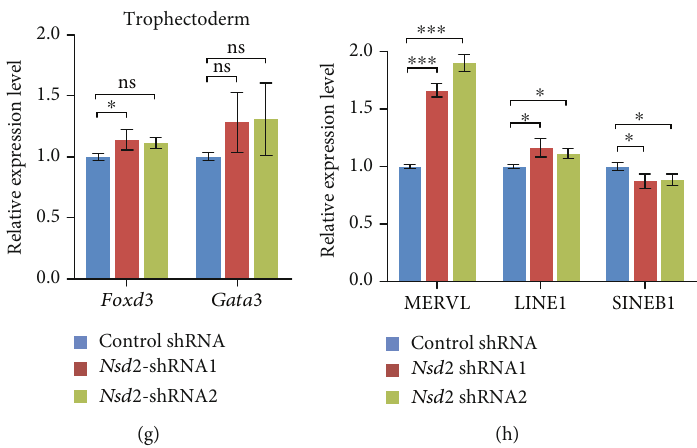
Figure 2: Depletion of Nsd2 in ESCs. (a) qPCR analysis of the relative expression levels of Nsd2 after Nsd2 depletion in ESCs with normalization to Gapdh . Data were plotted as mean ± s : e : m : , n = 3 biological repeats. (b) Cell morphology of Nsd2 depletion in ESCs. Scale bar, 100 μ m. (c) qPCR analysis of pluripotent genes ( Oct4 , Sox2 , and Nanog ) in ESCs with Nsd2 depleted. (d – g) qPCR analysis of endoderm markers Foxa2 and Sox17 (d), mesoderm markers Gata4 and Nkx2.5 (e), ectoderm markers Msx1 and Pax6 (f), and trophectoderm markers Foxd3 and Gata3 (g). (h) qPCR analysis of the expression levels of MERVL and other retrotransposons (LINE1, SINE B1) after Nsd2 depletion in ESCs. The results were normalized to Gapdh . Data were shown as mean ± s : e : m : ; n = 3 biologically independent replicates; ns: nonsigni fi cant; ∗ p < 0 : 05 ; ∗∗ p < 0 : 01 ; ∗∗∗ p < 0 : 001